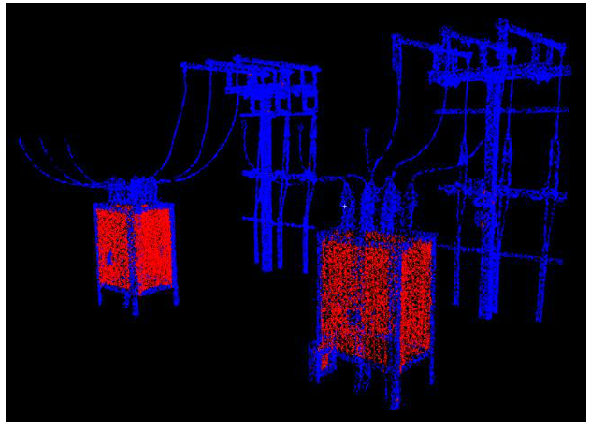
Figure 14. Results of the proposed segmentation method on circuit breakers using down-sampled Faro